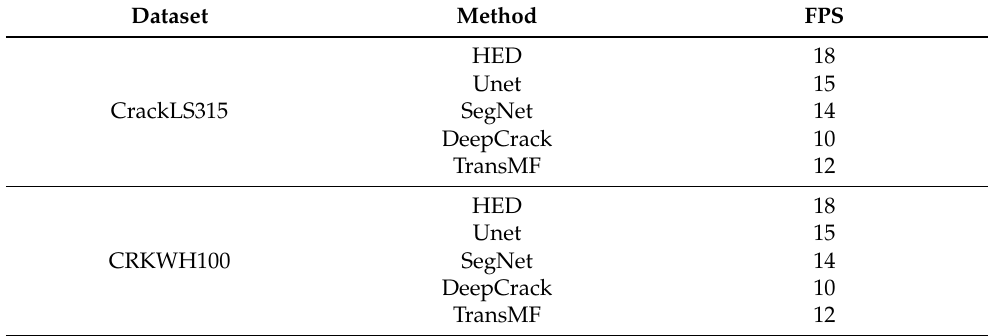
Table 3. Time costs on two